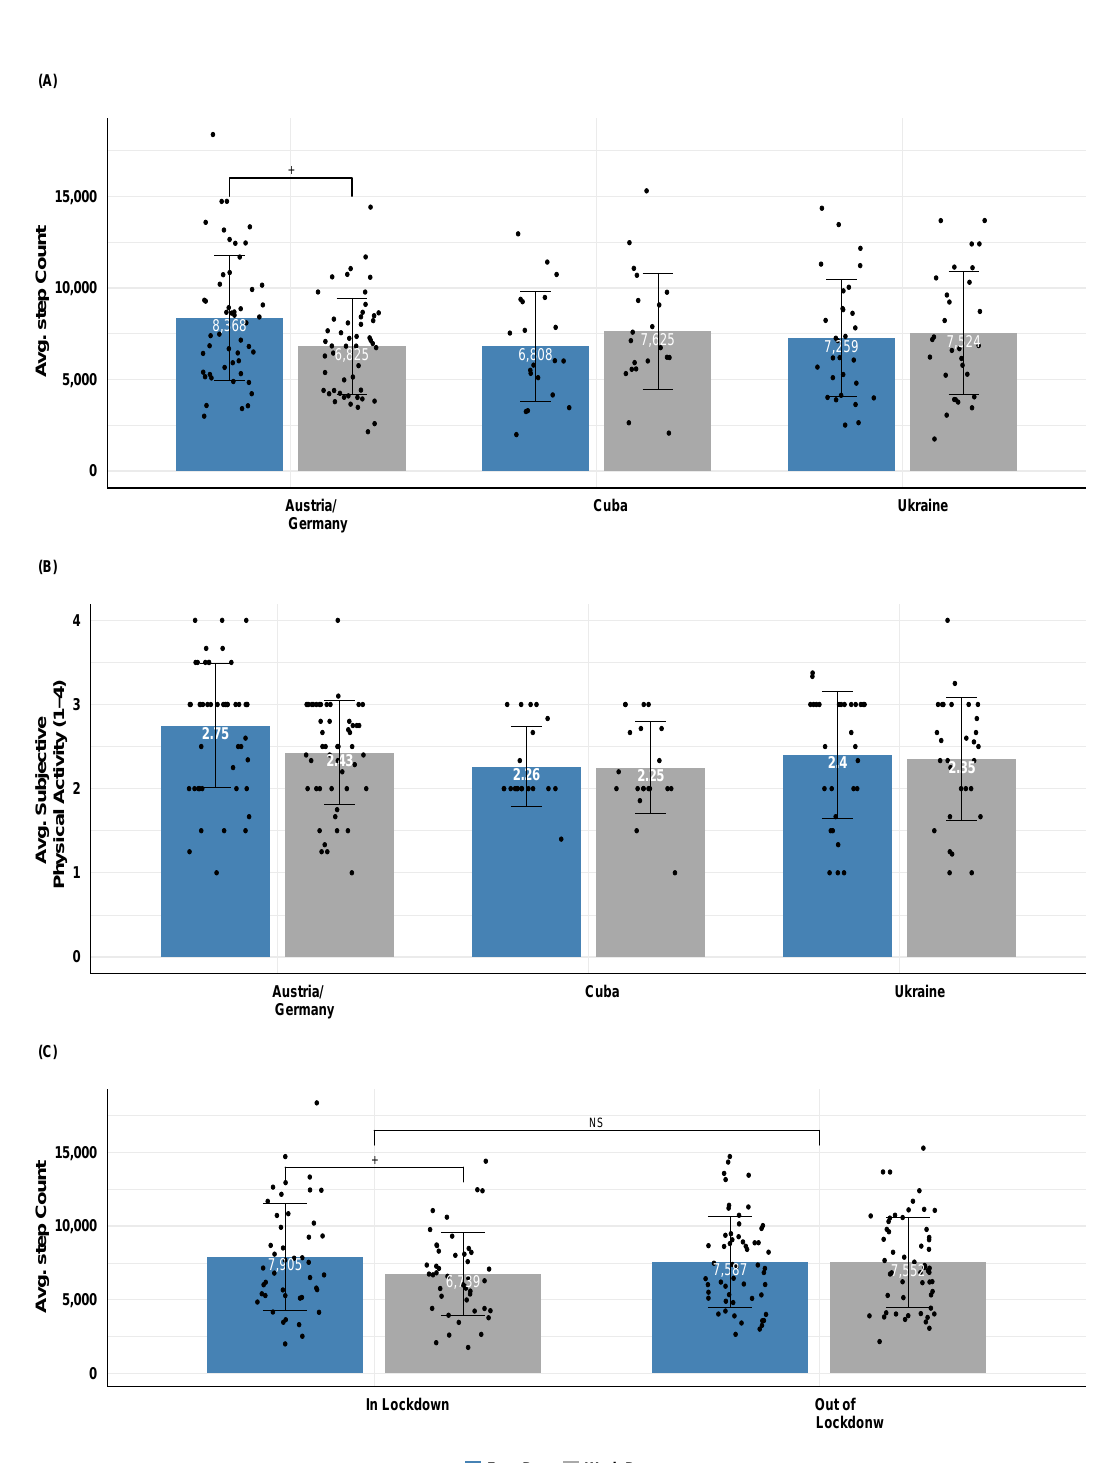
Figure 3. Subjective physical activity and objective step count differences across countries. ( A ) Mean step count for each country (Austria and Germany, Cuba, and Ukraine) and day (work or free), as extracted by MB. Note that it was indicative that in Austria there were more steps during free compared to workdays. ( B ) Mean subjective physical activity (1 = not at all, 4 = a lot) for each country and day. ( C ) Mean MB step count for in and out of lockdown participants, separately for work and free days. Note that there was no significant effect between in and out of lockdown. Error bars indicate the standard deviation of the mean. Bonferroni-corrected pairwise marginal mean comparisons indicate significance at <0.1+, <0.05 *, <0.01 **, <0.001 ***, and non-significant (NS)